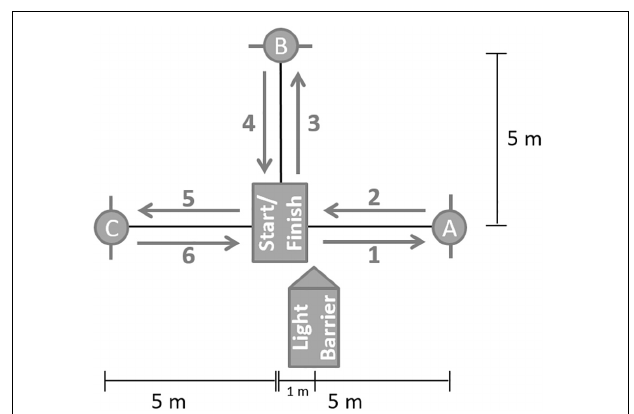
FIGURE 2 | T-run: Cone A, B, and C had to be reached after one another by a forward sprint (1–5). Marks on the floor must be crossed at each corner. After cone C (6), participants could run as fast as possible across the finish line [adapted from McBride et al. (2002) and Reiman and Manske